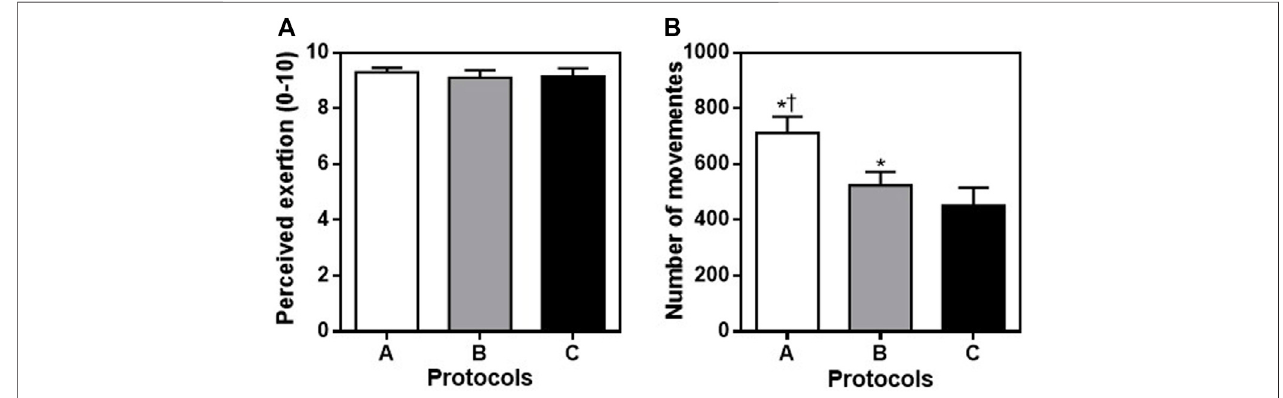
FIGURE1| Valuesexpressedatmean±DPforperceivedexertion[Panel (A) ]andnumberofmovements[Panel (B) ]forprotocolA(jumpingjack,burpee,mountain climb and squat jump), protocol B (jumping jack, mountain climb, burpee, and squat jump) and protocol C (burpee, squat jump, jumping jack and mountain climb). * p < 0.001 vs. protocol C † p < 0.001 vs. protocol